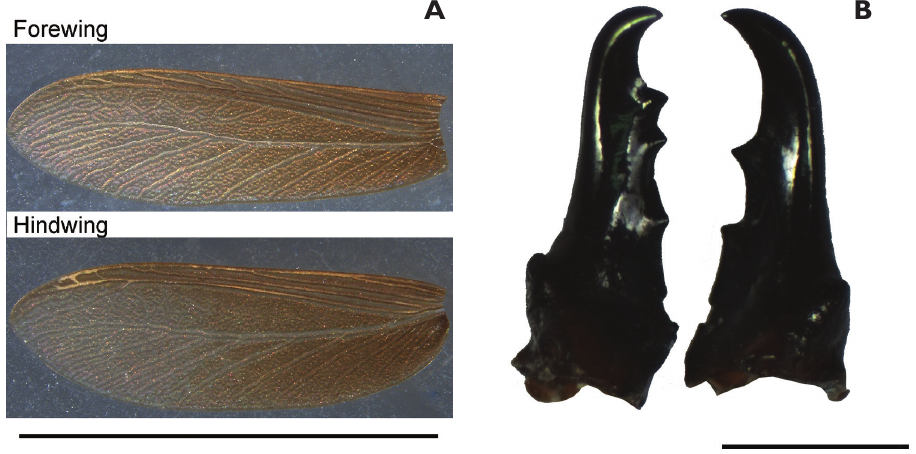
Figure 3. Proneotermes macondianus sp. n. Alate: A fore- and hindwing, scale bar: 5 mm. Soldier: B mandibles, scale bar: 1 mm. Table 2. Morphometrical measurements for P. macondianus sp. n. imagoes. No. Measurements in mm (n